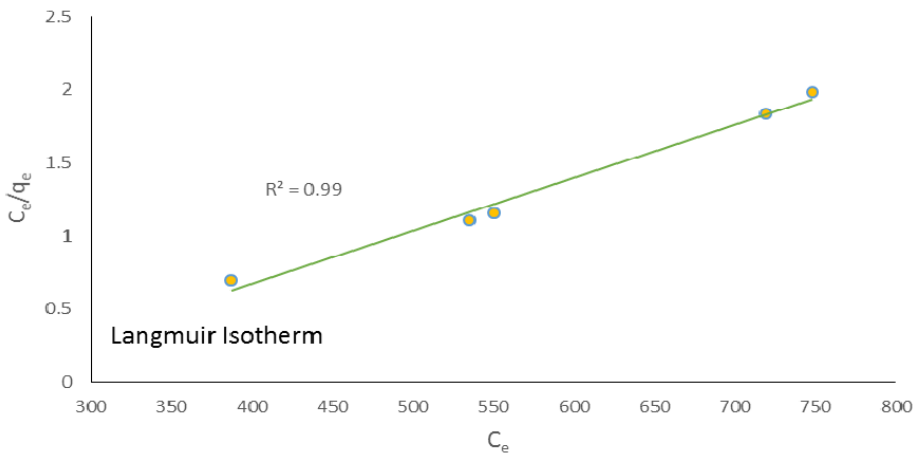
Fig. 9: Langmuir Isotherm for adsorption of Methylene blue by OPKS based activated carbon Table 4: Costing of produced activated carbon via OPKS biochar Item Time (min)